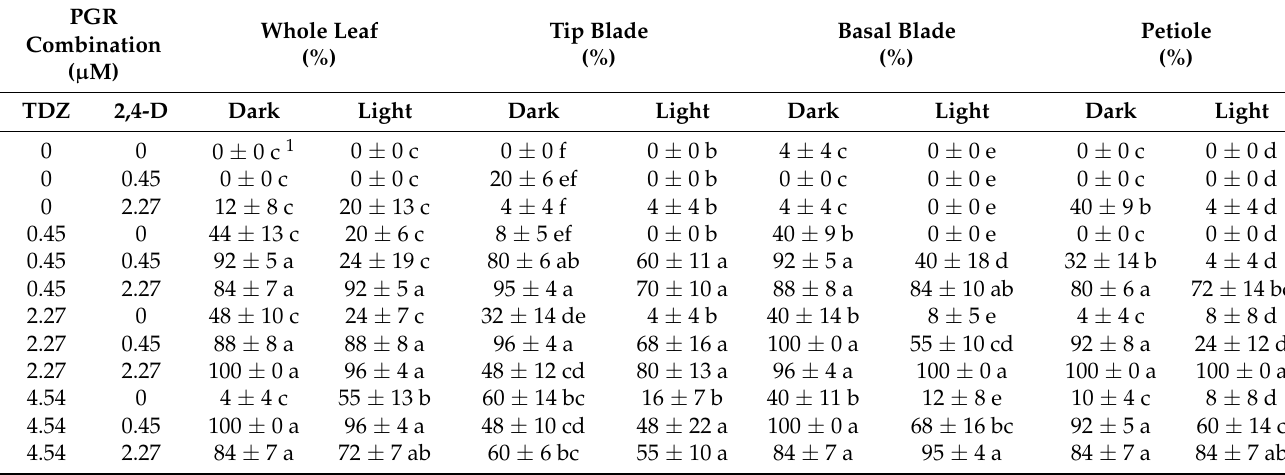
Table 3. Effect of the thidiazuron (TDZ) and 2,4-dichlorophenoxyacetic acid (2,4-D) combination on the callus induction rate from different strawberry ( Fragaria vesca ) explants after 4 weeks of culturing.